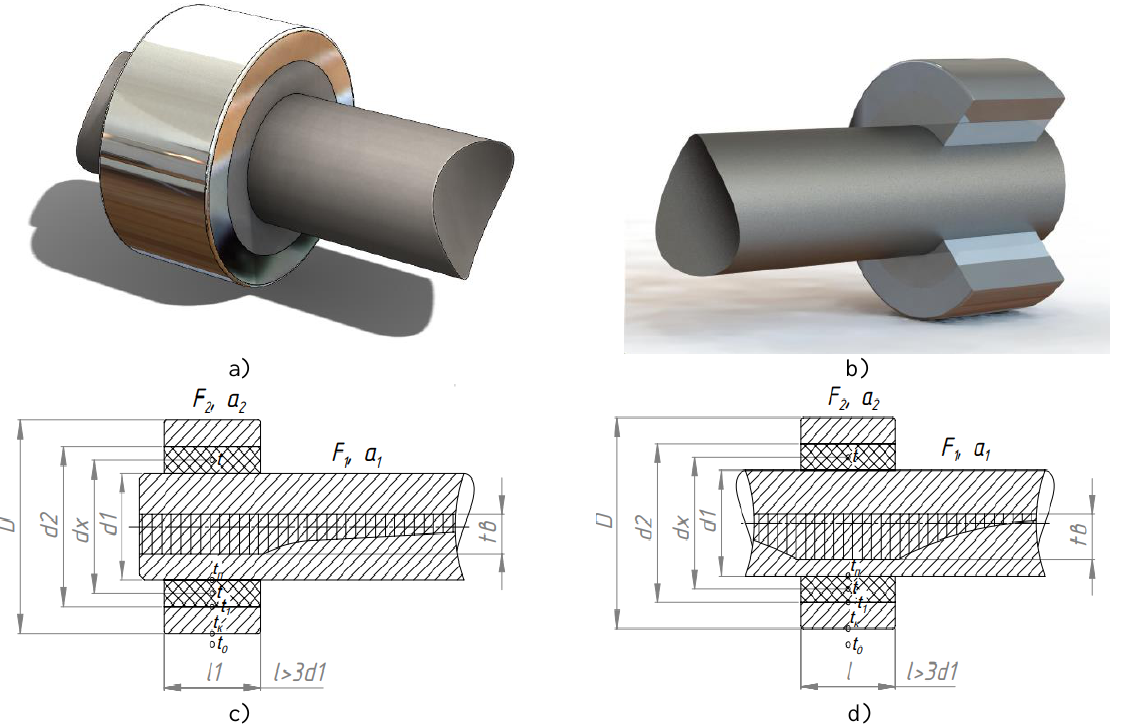
Fig. 1. Diagram of the bearing unit filled polymer: a, b – bearing units modelled using DS SolidWorks 2020; с - end bearing; d -median bearing; d 1 - shaft diameter in the friction zone; d 2 - outer diameter of bearing; D – outer bearing housing diameter; l - bearing length; L - length of shaft with intense heat exchange, tв – temperature distribution at shaft operation.